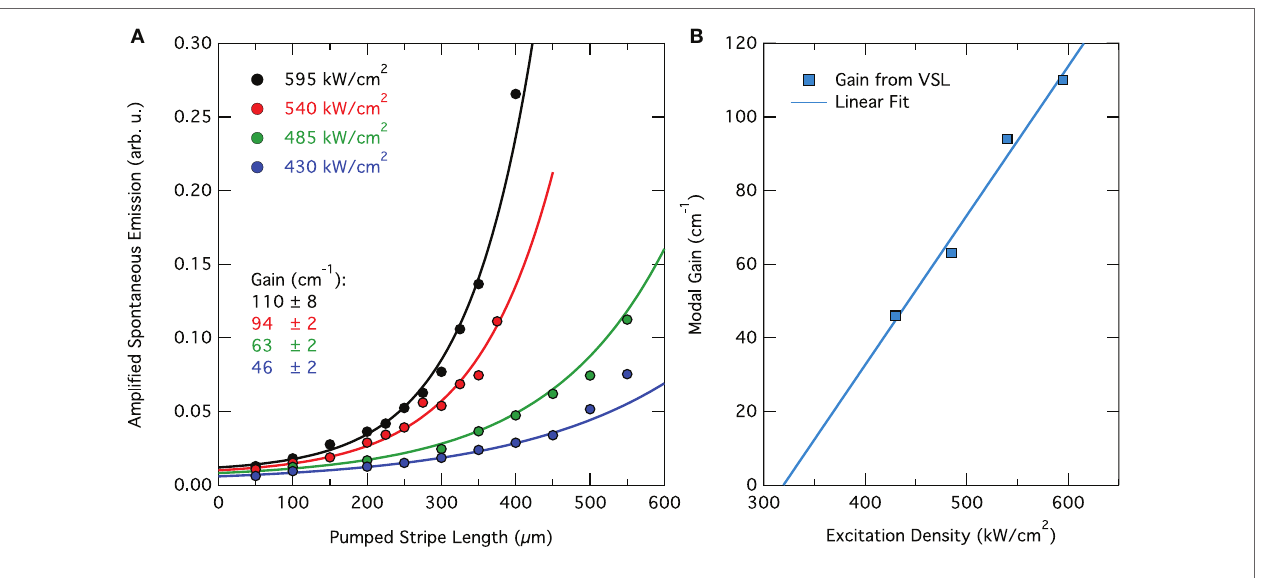
extracted by an exponential fit to the data. (B) Differential gain extracted from the spectra in (A) indicating a linear dependence on excitation density with a threshold at 325 kW cm − 2